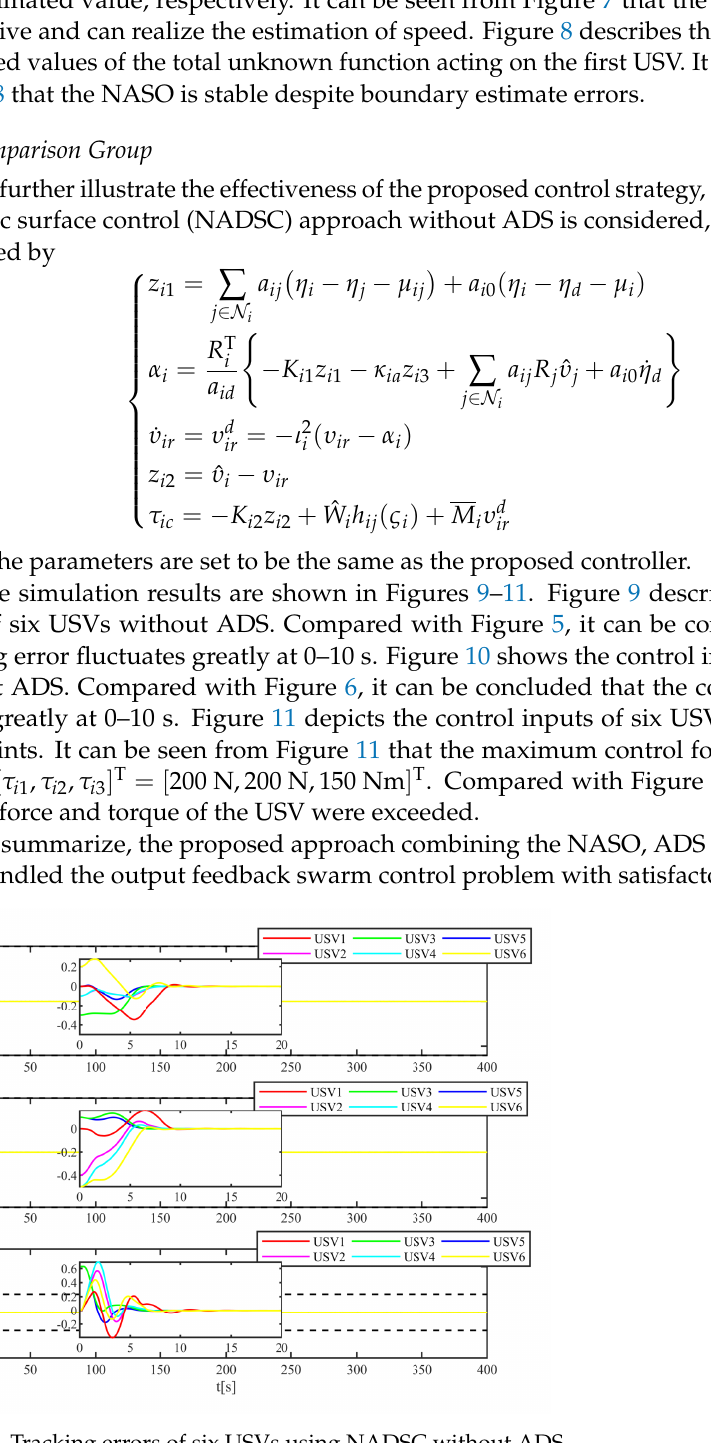
Figure 9. Tracking errors of six USVs using NADSC without